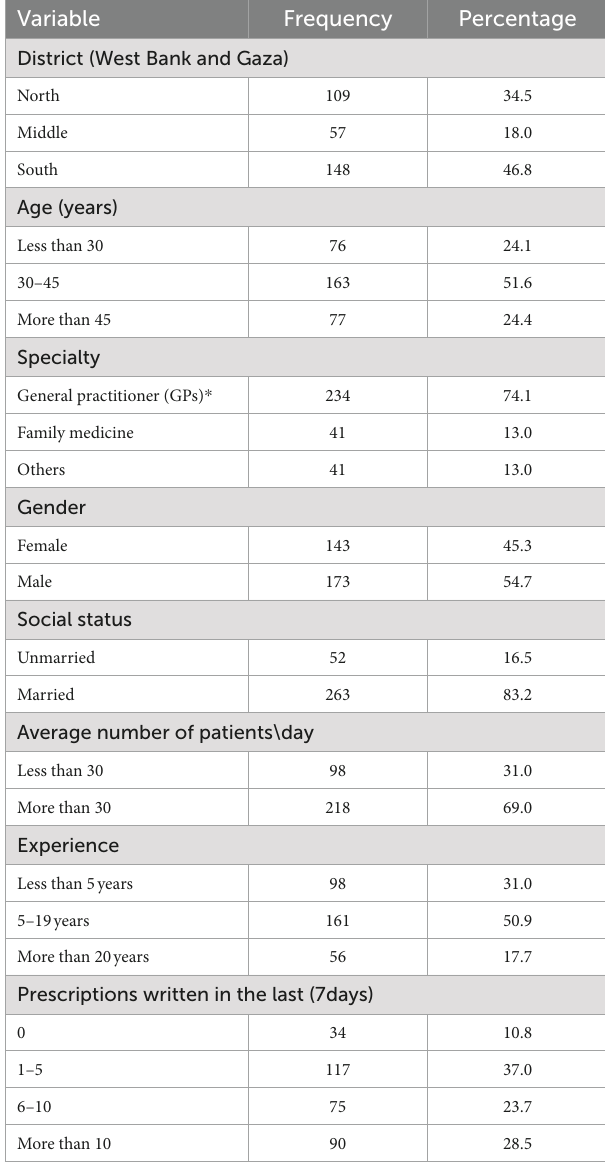
TABLE 1 Sociodemographic characteristics of the studied sample ( n =